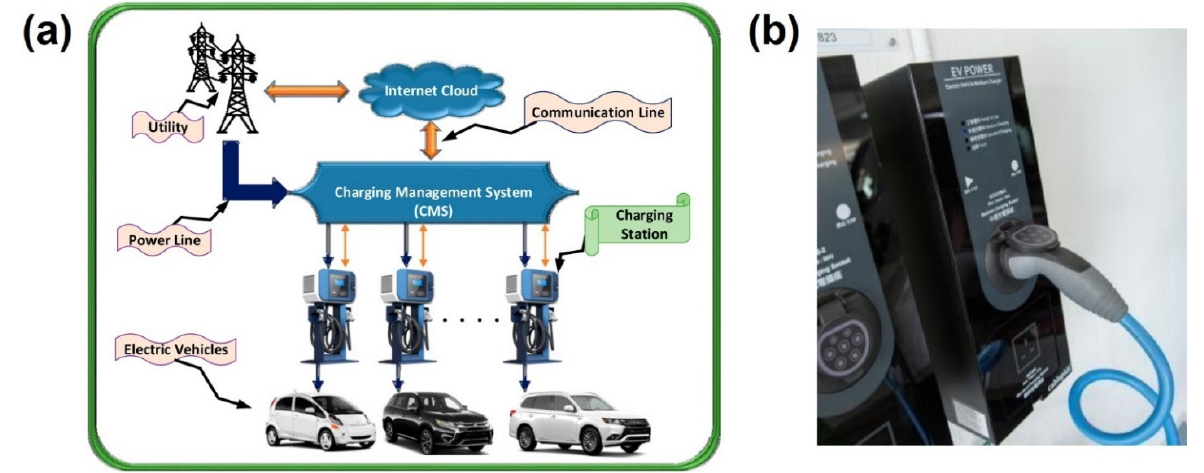
Figure 4. ( a ) Schematic diagram of smart power distribution [51]; ( b ) “Charging Pro” developed by APAS and